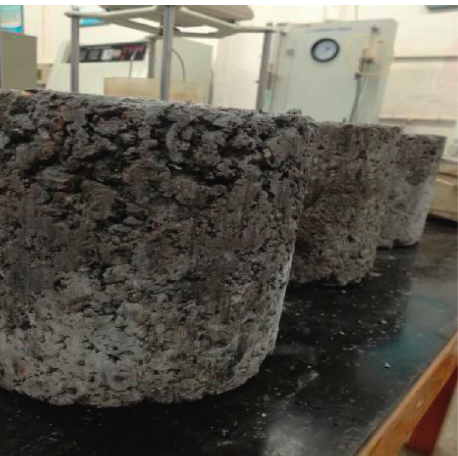
Figure 10: Specimens after freezing and thawing.